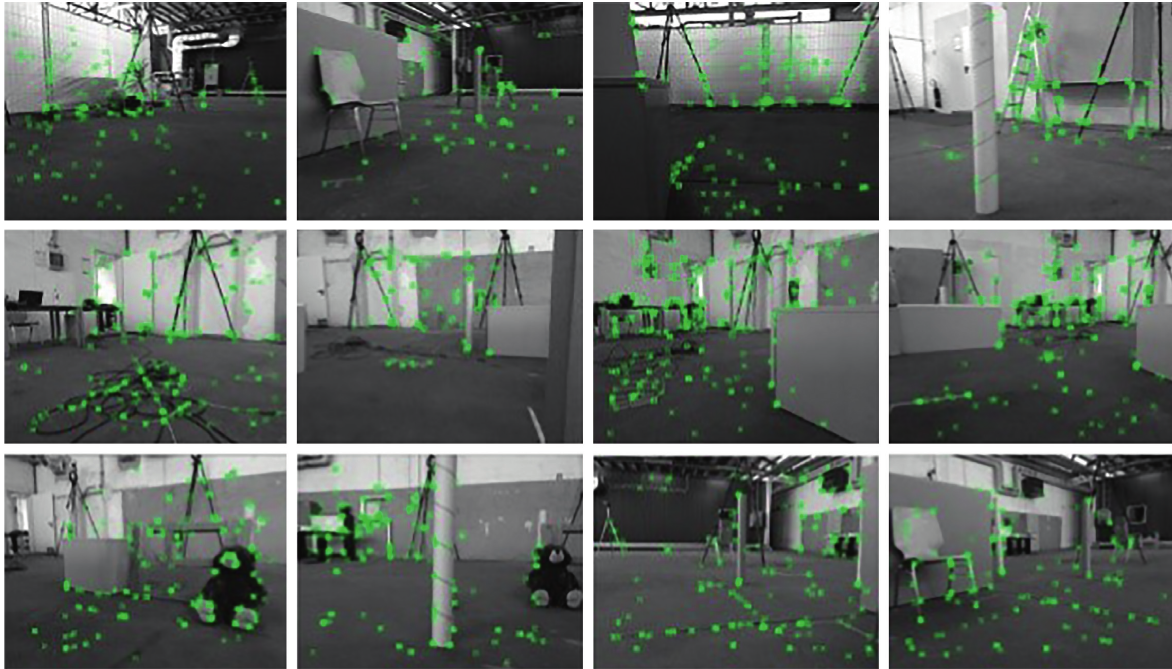
Figure 5: ORB feature extraction